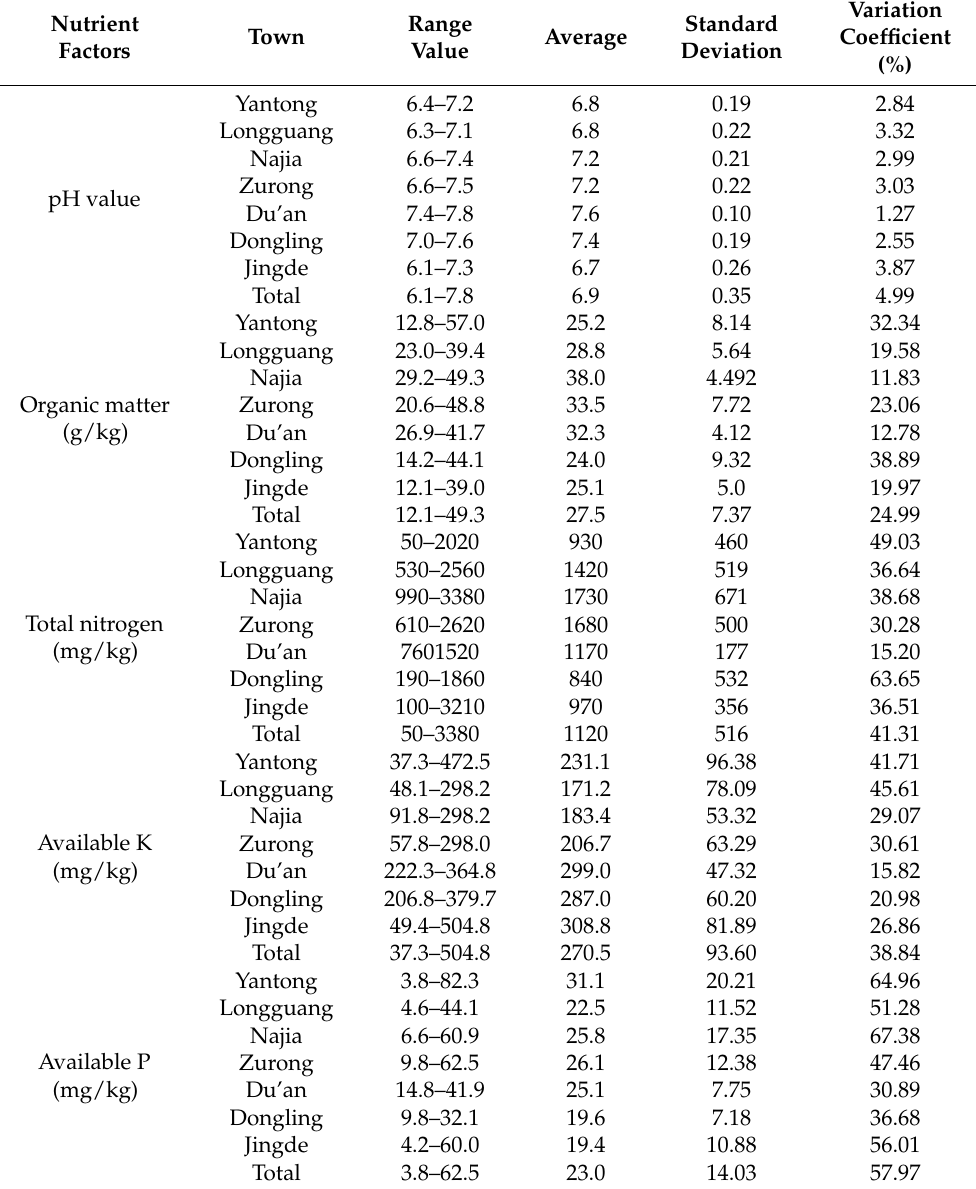
Table 3. Soil pH values, organic matter, total N, available K, available P content in seven tobacco planting towns of Debao